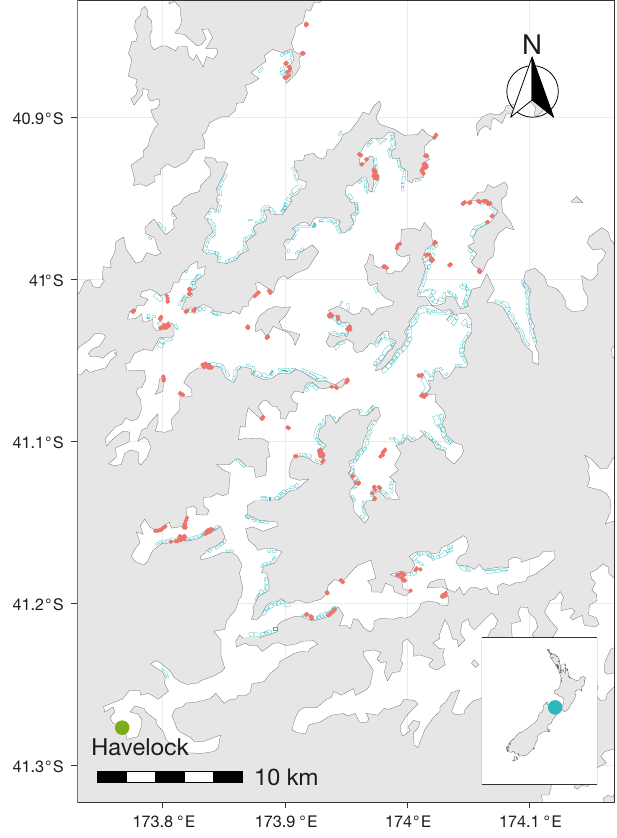
Fig. 1. Map of the study area showing active green-lipped mussel Perna canaliculus farms (blue polygons) and sampling sites (red circles) in Pelorus